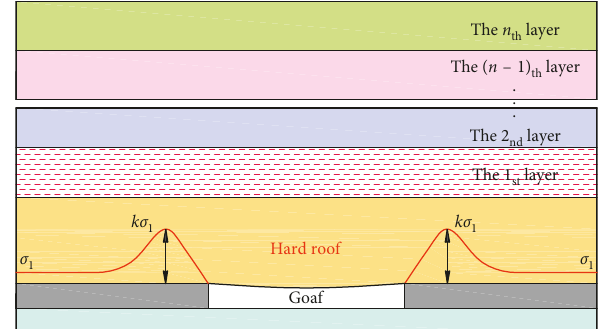
Figure 1: Diagram showing the bending deformation distribution of a hard